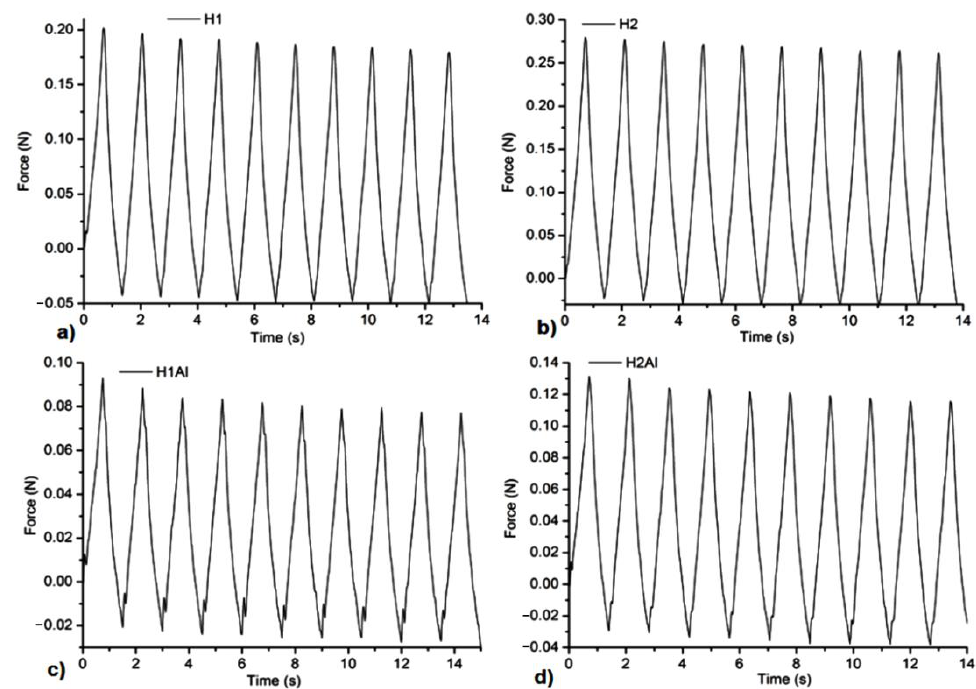
Figure 5. Compression tests of the samples at 20% compressive strains: a ) — H1, b ) — H2, c ) — H1Al,and d ) — H2Al.